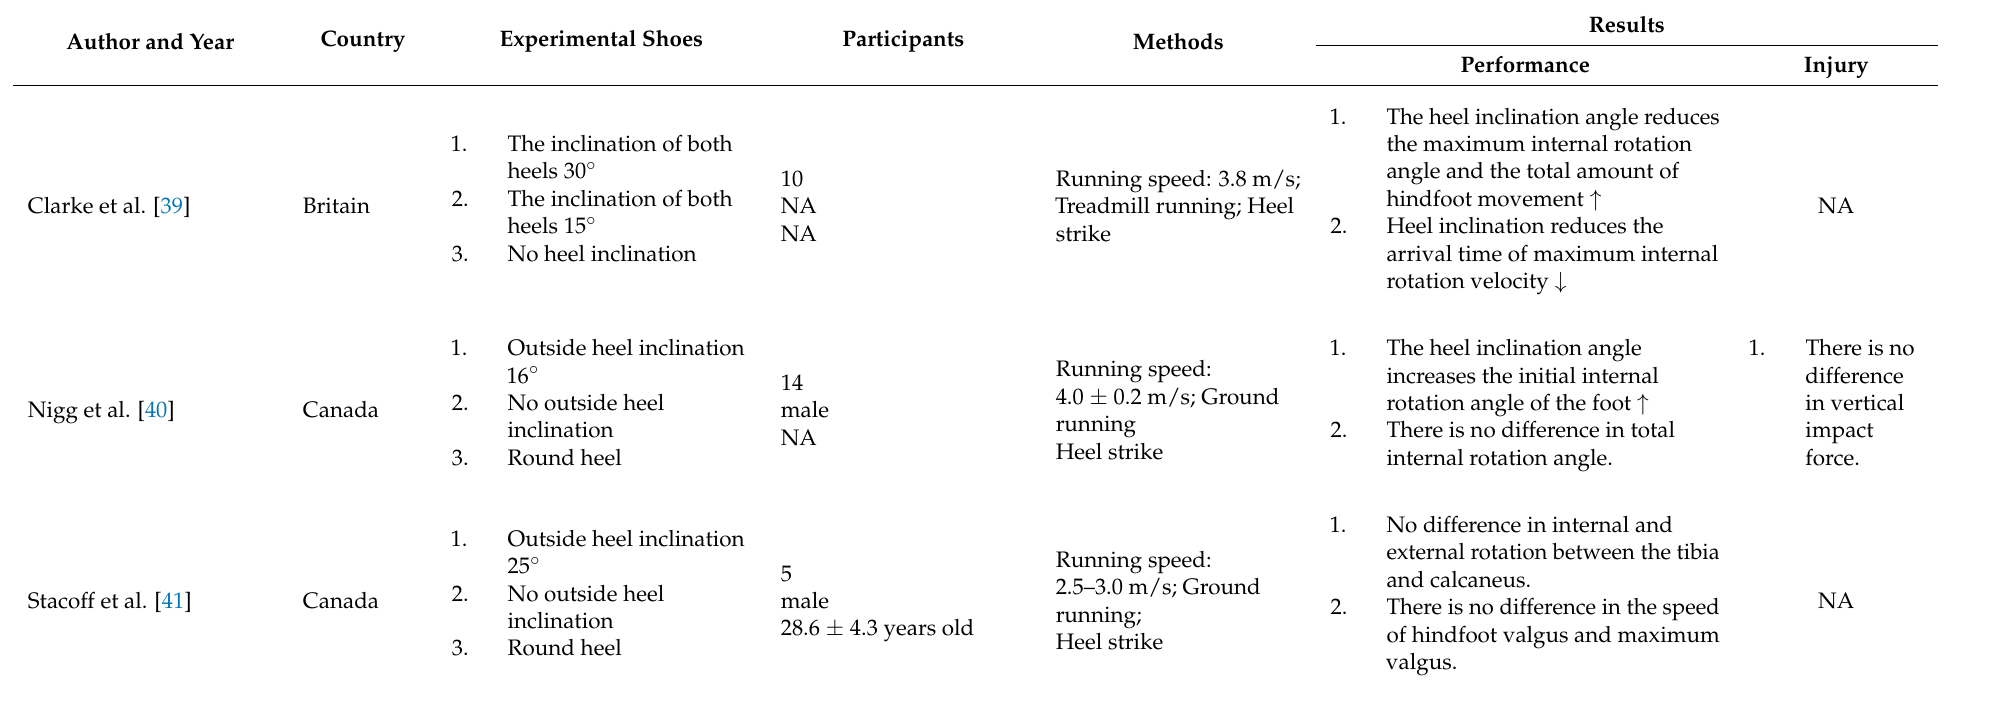
Table 5. The influence of running shoes’ heel flare on running performance and related